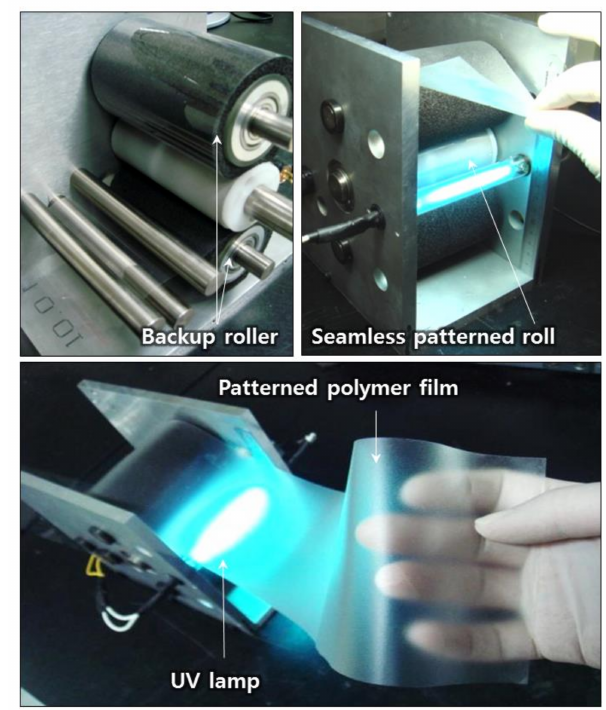
Figure 8. Digital pictures showing the roll-to-roll equipment and an example of replicated superhydrophobic polymer